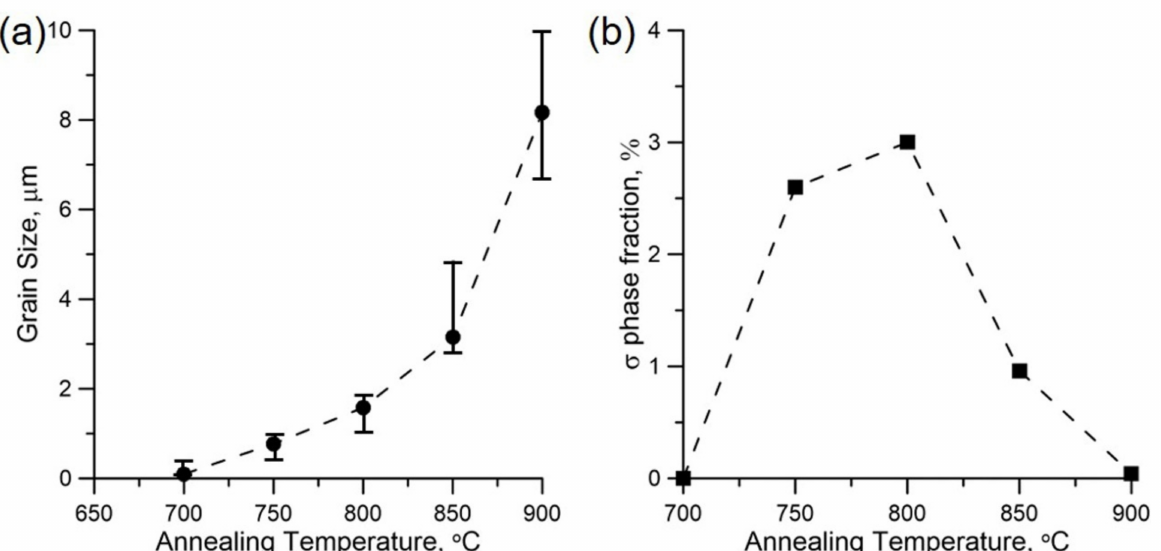
Figure 4. ( a ) Grain size; ( b ) σ phase volume fraction of HPT-produced 316LN steels under different annealing